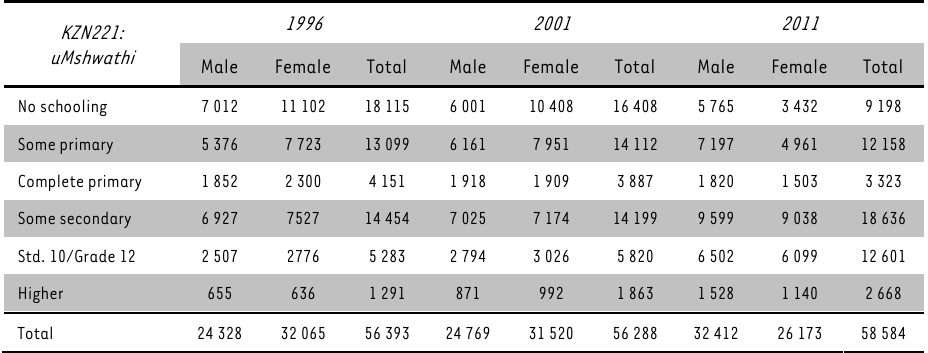
Education Statistics by Gender, uMshwathi Local Municipality: 1996, 2001 and 2011. KZN221: